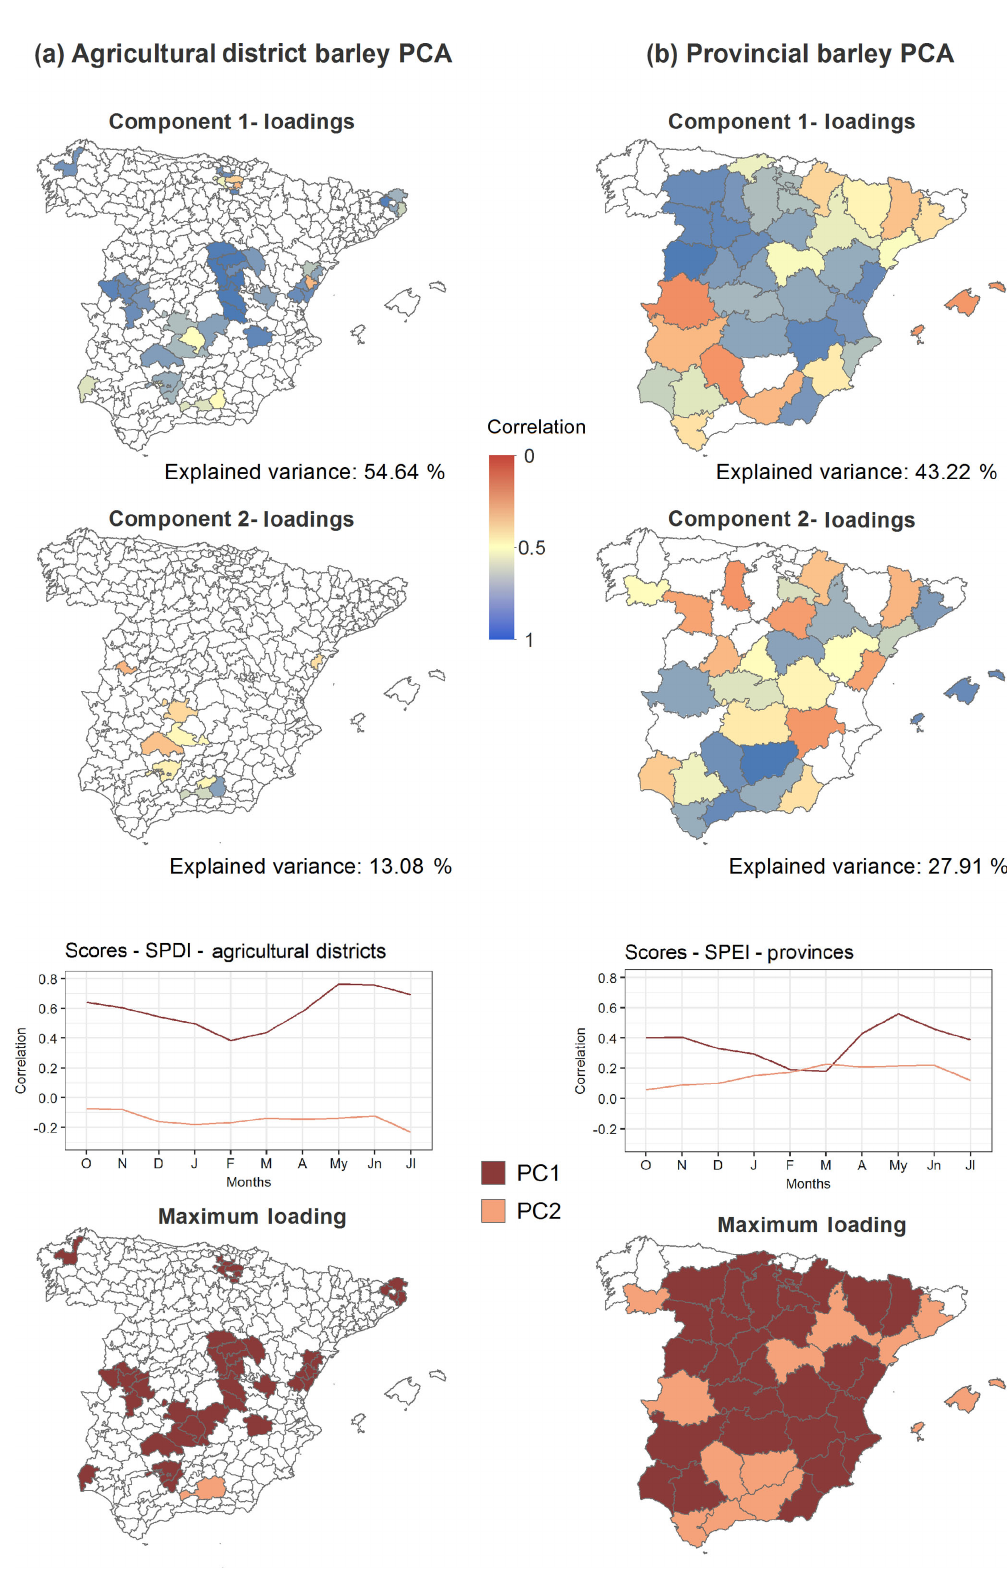
Figure 8. PC loadings, PC scores, timescales, and maximum loading rules from the PCA for monthly maximum correlation coefficients be- tween the SPEI and barley yields at the agricultural district scale (a) and the SPDI and barley yields at the provincial scale (b) , independently of the timescale. The PC loadings and maximum loadings were significant at p < 0 .